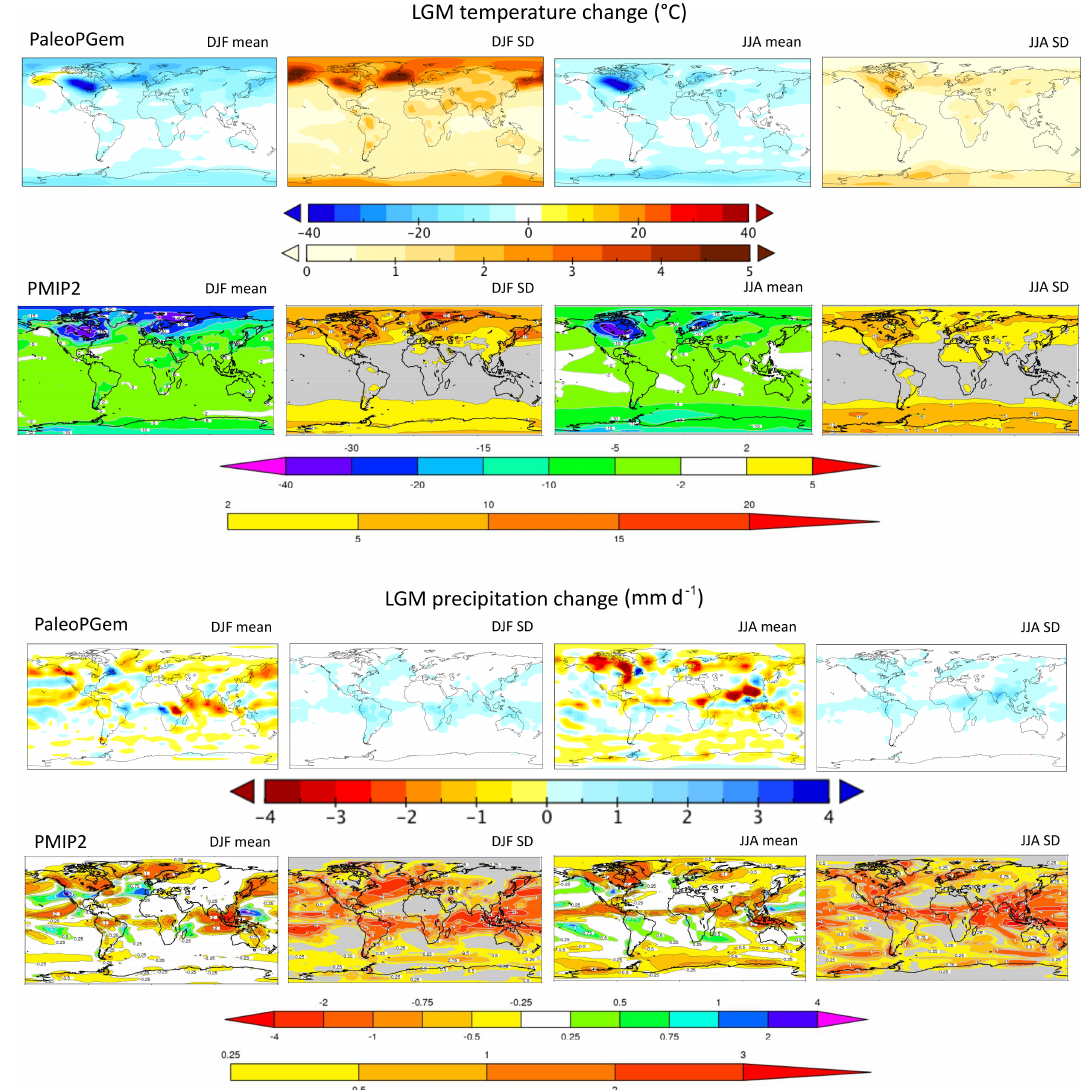
Figure 4. PALEO-PGEM emulated ensemble comparison with the PMIP2 ocean–atmosphere ensemble (Braconnot et al., 2007) for the Last Glacial Maximum. Note the different scales for SD temperature. Reduced variance in PALEO-PGEM is due to the understated uncertainty of climate sensitivity, which arises from the neglect of parametric